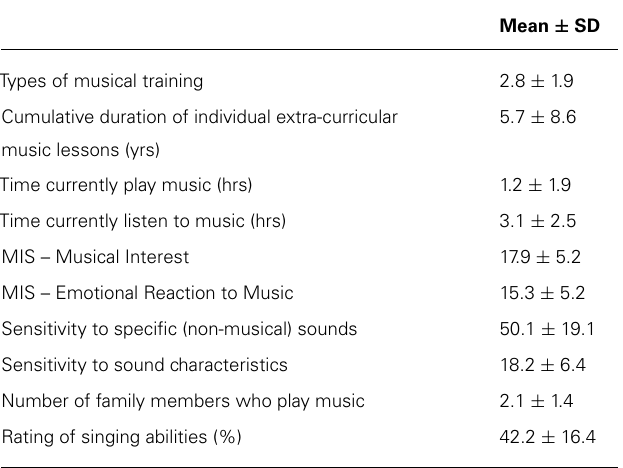
Table 2 | Musical background and skill.